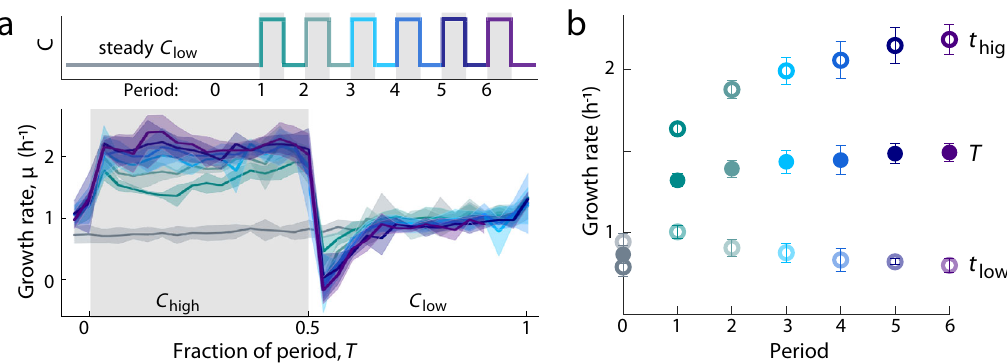
Fig. 5 Rapid nutrient fl uctuations induce the transition to a fl uctuation-adapted growth physiology. a After at least 3.5 h of growth in steady C low , cells experience the onset of nutrient fl uctuations ( T = 60 min) between C low and C high . The growth rate dynamics in response to each successive nutrient period transition from the dynamics observed in response to a single shift to those observed in fl uctuating environments (Fig. 4b). The growth rate dynamics of the successive periods, including the 60 min preceding the fi rst nutrient upshift (period 0), are overlaid to show the stabilization of the growth rate signal. Shaded error bars denote the standard deviation of the mean among replicate experiments ( n = 3). b Stabilization of growth rate dynamics with successive nutrient periods. The mean growth rate following each downshift (half-period in C low , t low ), each upshift (half-period in C high , t high ) and across the full period ( T ) adjusts and stabilizes by the third period. Error bars denote the standard error of the mean ( n = 3) and are smaller than points when not